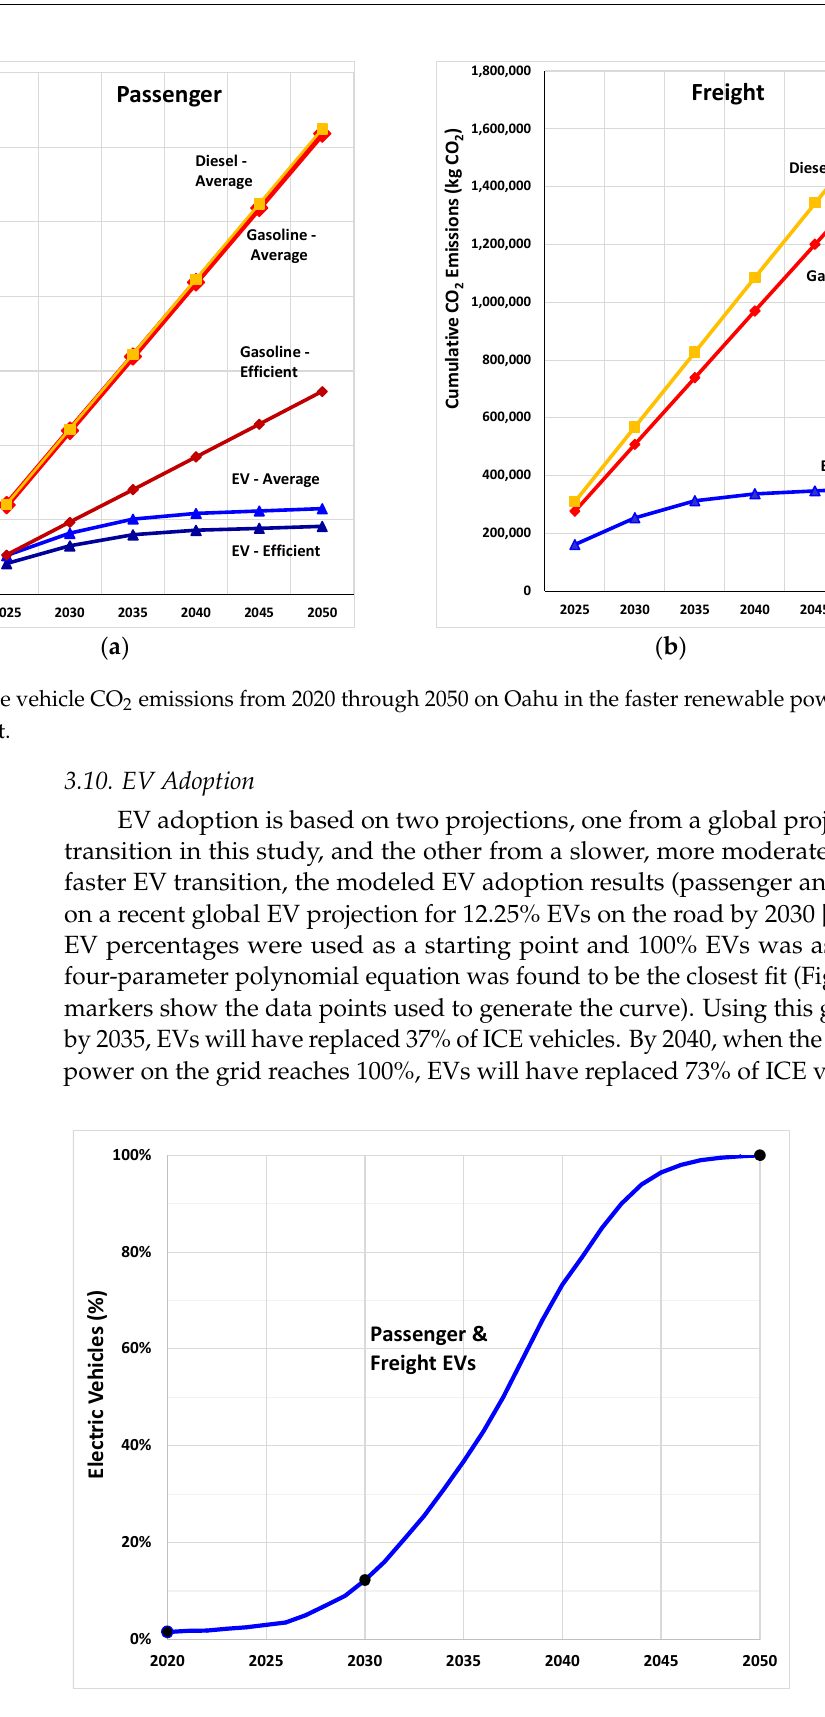
Figure 11. Modeled EV adoption for passenger and freight vehicles based on a global projection to reach 12.25% EVs on the road by 2030, and continuing that trend for Oahu to reach 100% by